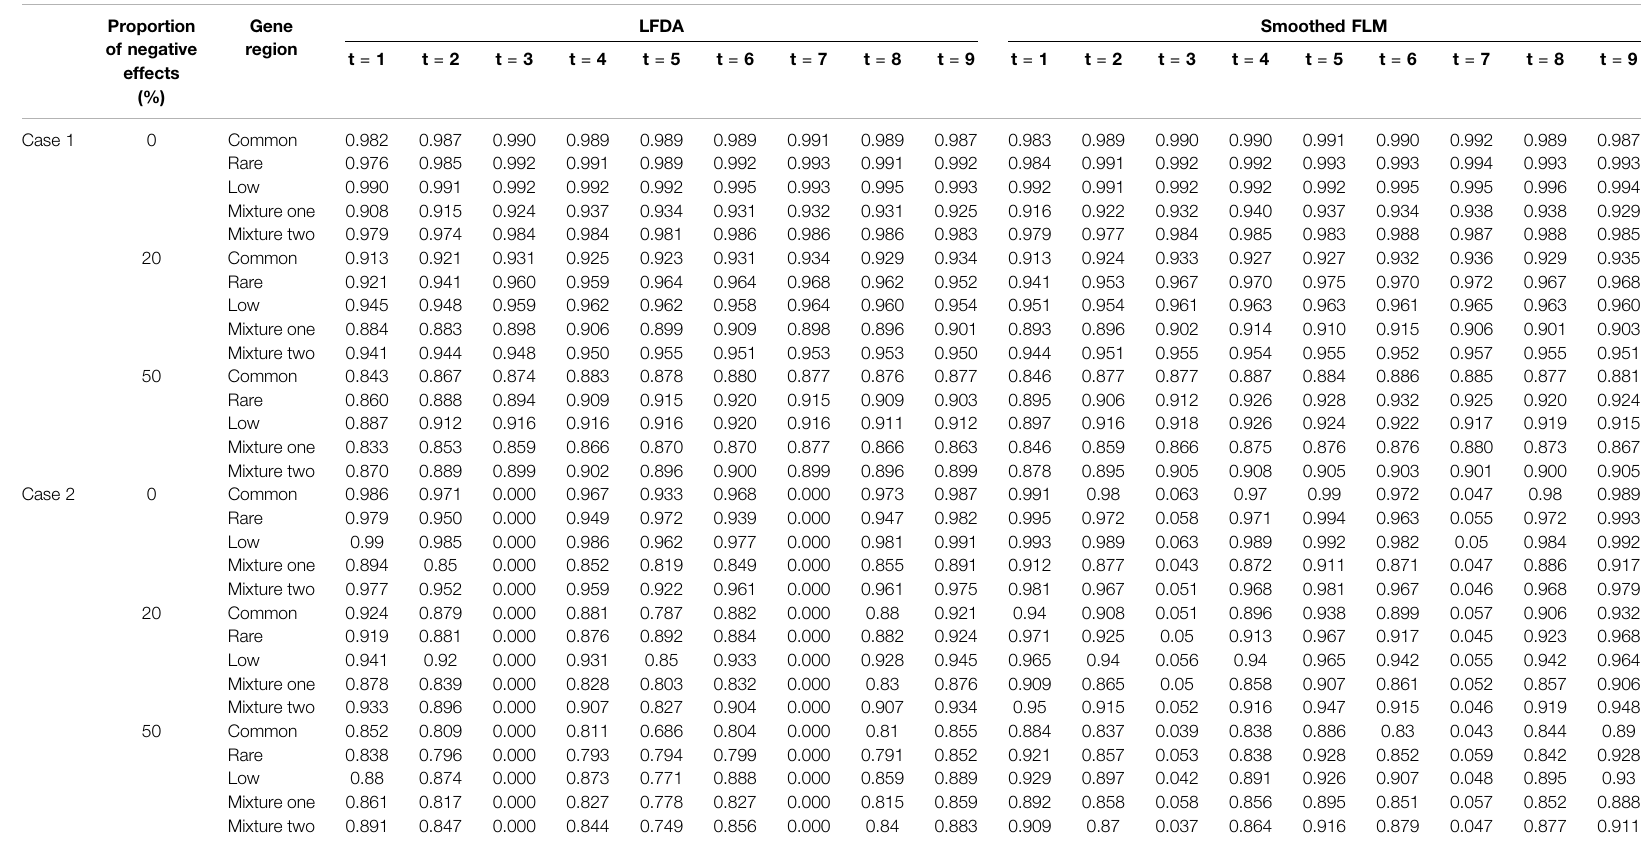
TABLE 2 | The power of linkage equilibrium simulation based on LFDA and Smoothed FLM at signi fi cance level of 0.05 when sample size is 2000, c is 7 and proportion of causal variants is 1%. Proportion of